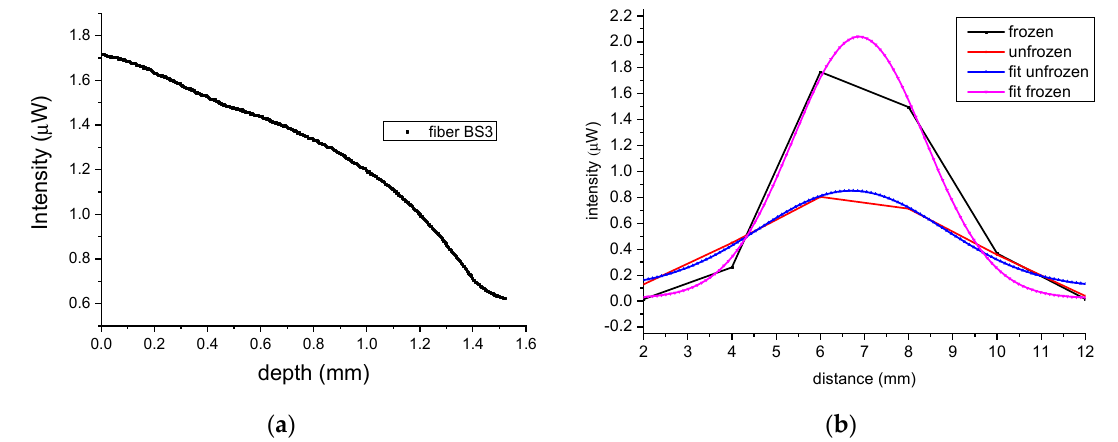
Figure 8. ( a ) Backscattering intensity variation with depth of freezing for the fiber array sensor. ( b ) Optical diffusion in mm.